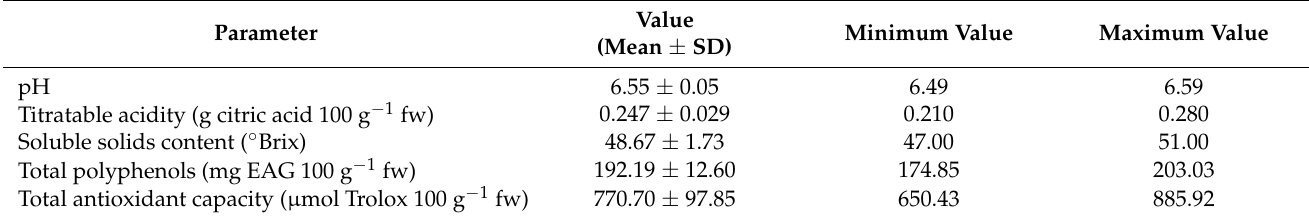
Table 9. pH, titratable acidity, soluble solids content, total polyphenols and total antioxidant capacity parameters for fresh weight of hackberry fruits (mean ± SD, minimum and maximum value, n =